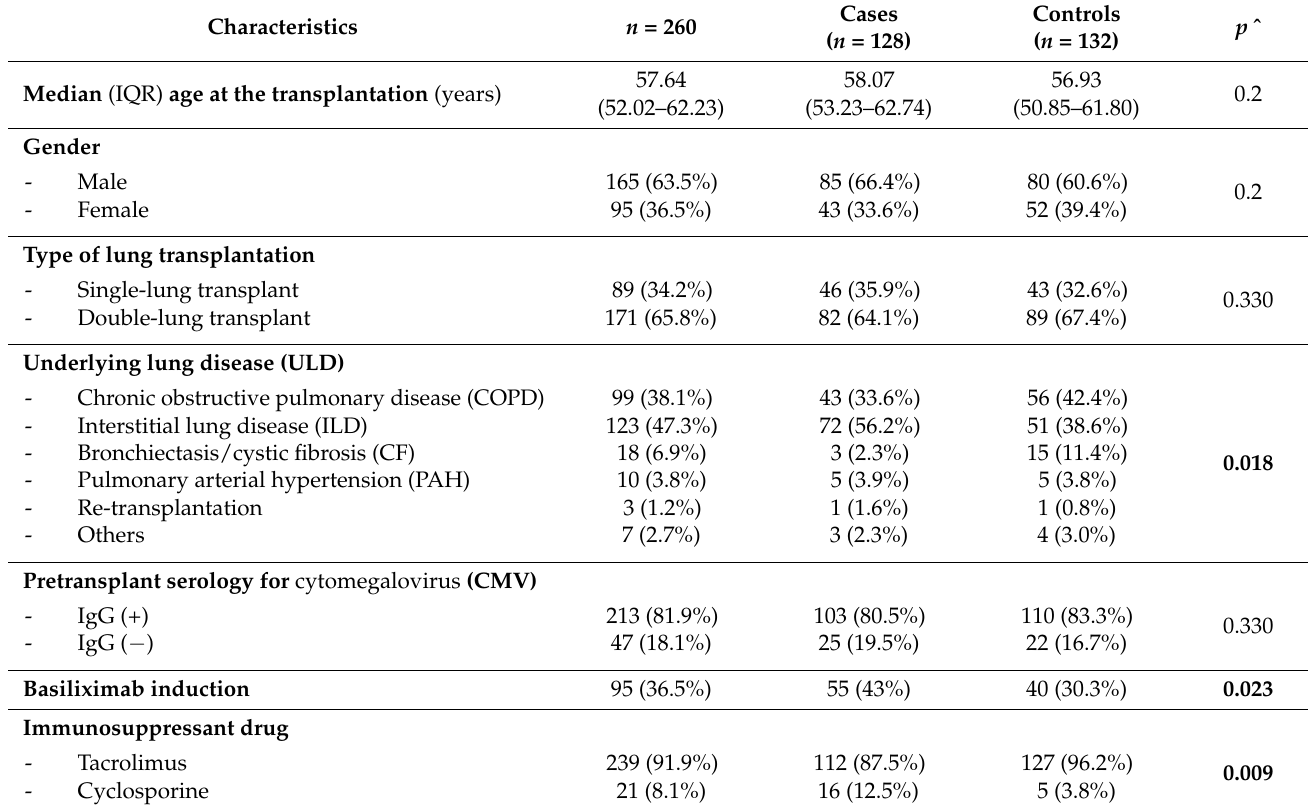
Table 1. Demographic